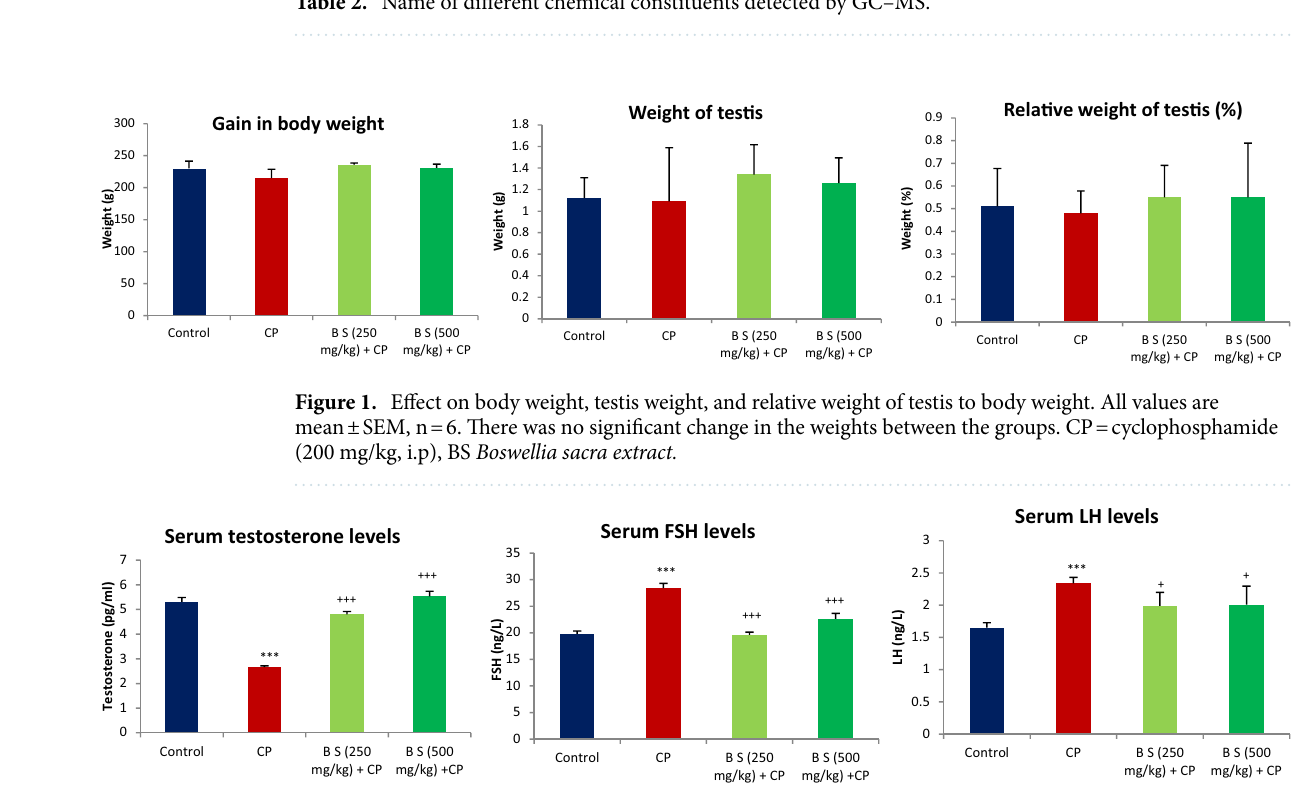
Table 2. Name of different chemical constituents detected by GC–MS.